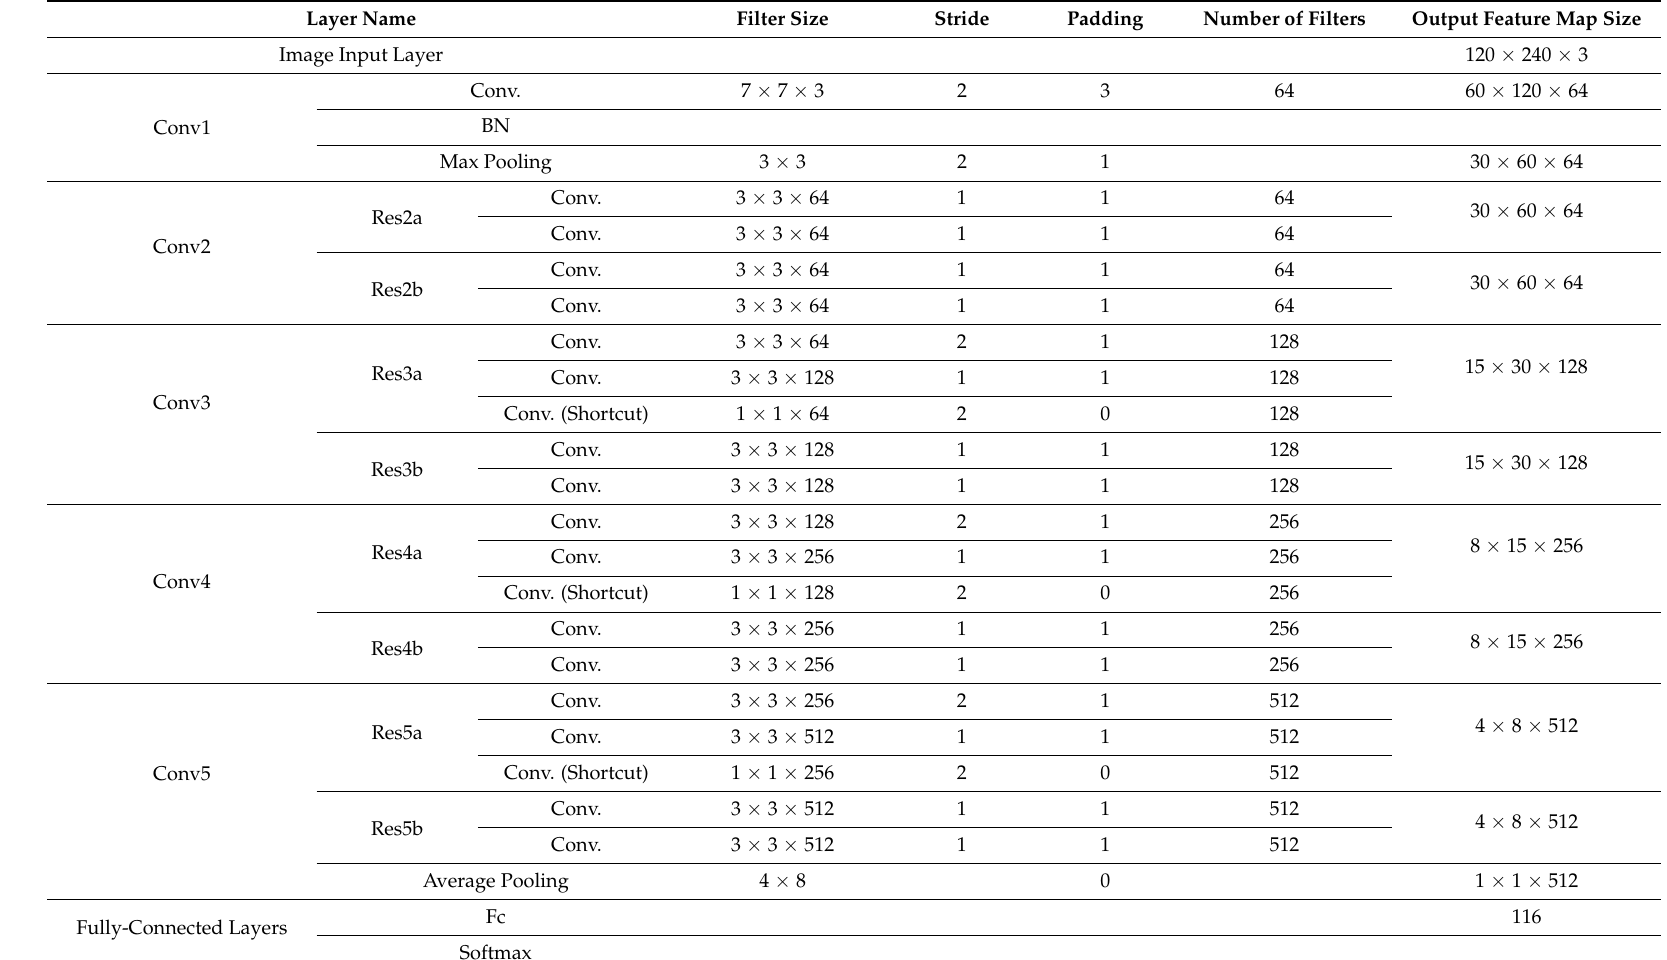
Table 5. Architecture of ResNet-18 used in this study (unit: